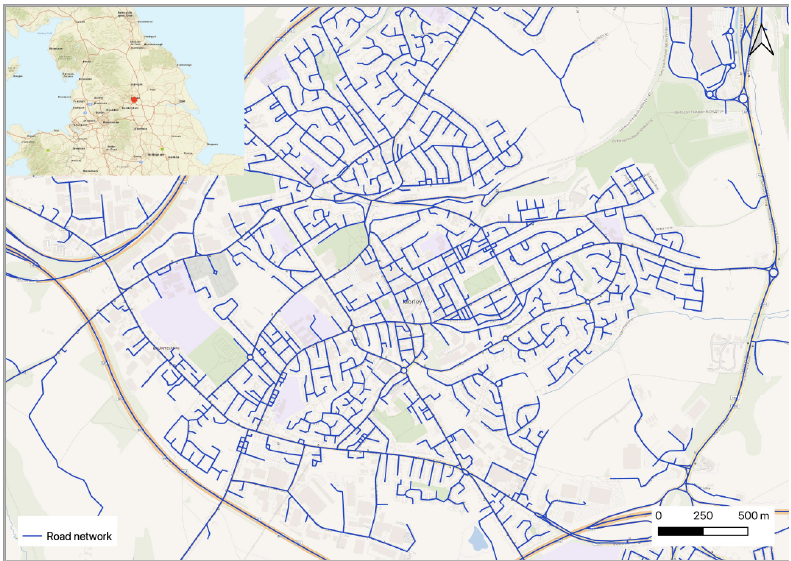
Figure 3. Urban Street Network of Morley, UK (data source: